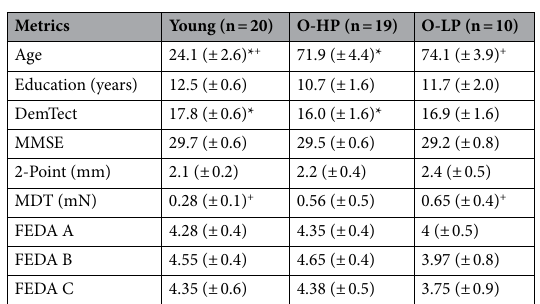
Table 2. Assessment data of the groups. Mean values are shown ± standard deviation. Based on significant main effects, post-hoc tests were conducted. *Indicate significant differences between Young and O-HP. + Indicate significant differences between Young and O-LP, all p-values ≤